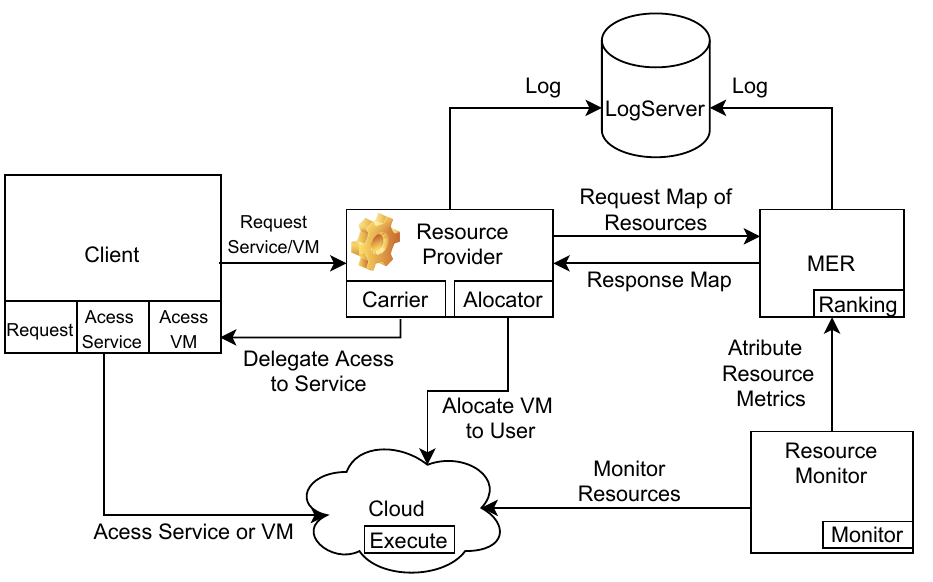
Figure 1. MoHRiPA architecture.